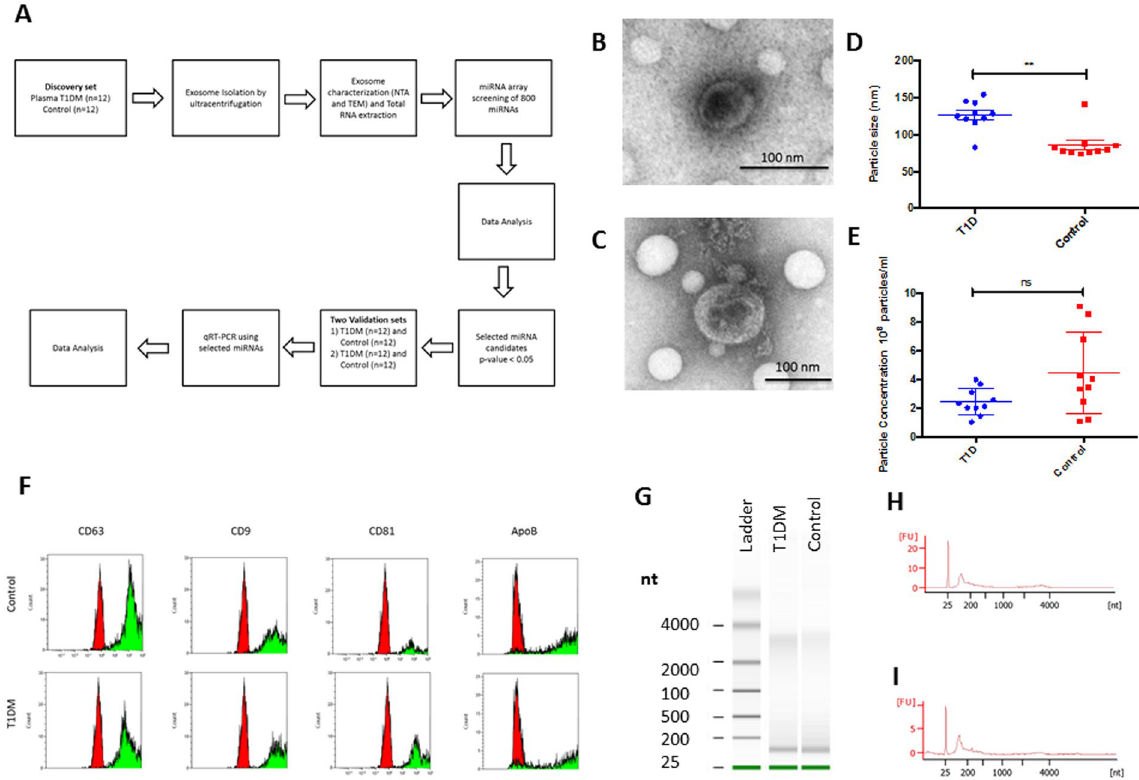
Figure 1. Work flow of study design and sample processing. Plasma from T1DM (n = 36) and control subjects (n = 36) was collected. Exosomes were isolated by ultracentrifugation and characterized by TEM and NTA analysis. Total exosome RNA was isolated and use for the miRNA microarray analysis (discovery set) or for the qRT-PCR validation (validation set) ( A ). Plasma exosomes were analyzed under electron microscopy which displayed the same morphology in T1DM and control subjects ( B , C ). Particle and Size distribution of exosomes analyzed by the Nanoparticle tracking analysis of T1DM and control subjects ( D , E ). Exosomal RNAs determined by the Agilent RNA Pico Chip. Exosomal RNA samples contained no detectable 18S and 28S rRNAs ( G ). Validation of selected exosome protein expression by flow cytometry (control read peak) ( F ). Small RNA Densitometry traces profiles were used to quantify and compare the relative abundance of various small RNAs in T1DM ( H ) and Control subjects ( I